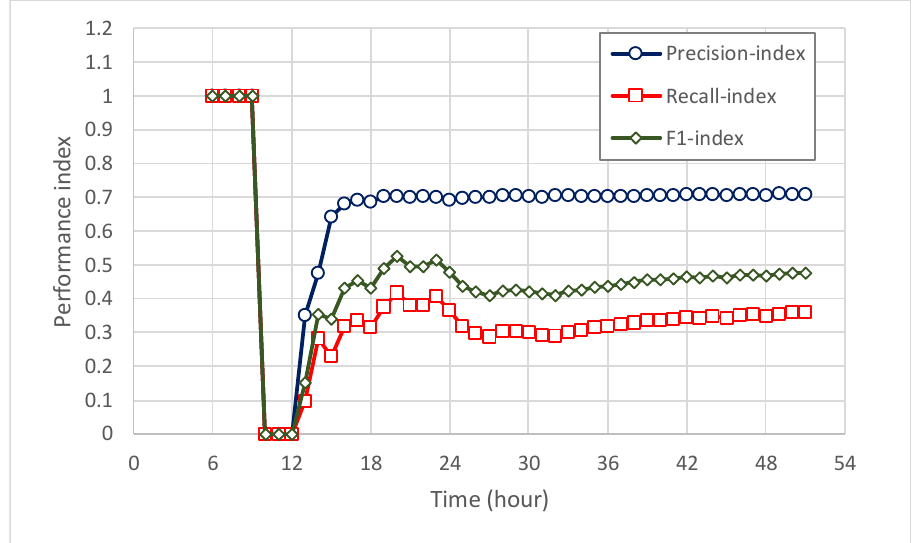
Figure 23. Summary of the performance indices of the estimated flooding region by the proposed SM_EID_VIOT model.